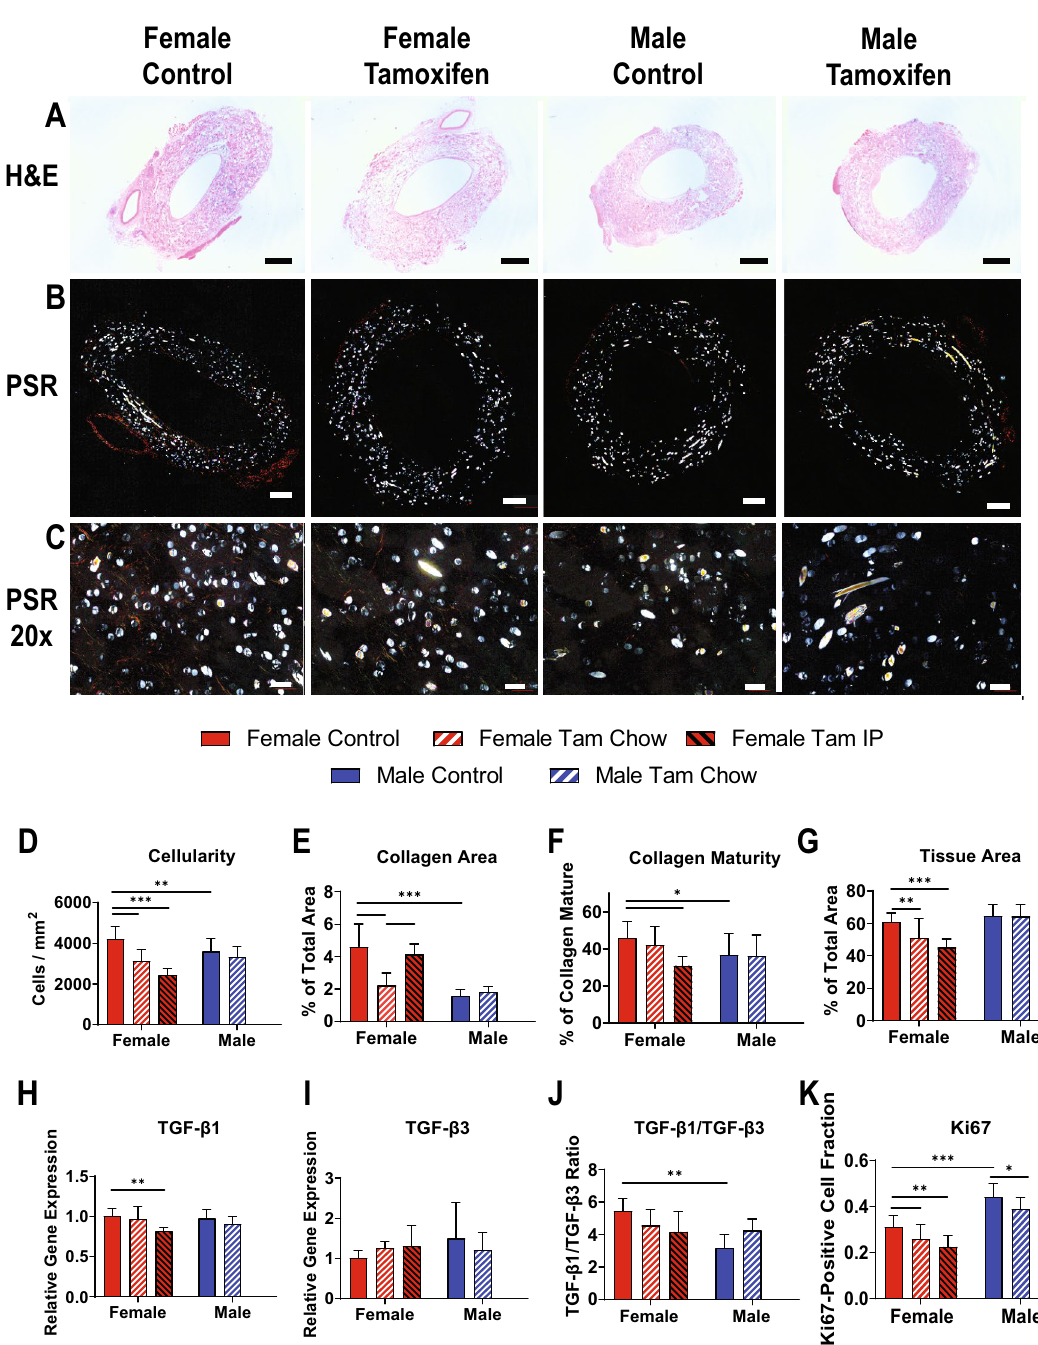
Figure 2. TEVG Neotissue Formation. ( A ) H&E imaging of TEVGs at the 2-week time point. ( B ) Picro-Sirius Red images under polarized light, with close-up of TEVG wall ( C ). White spots represent PGA fibers; red/ orange coloration represents mature thicker collagen fibers and yellow/green coloration represents thinner, immature collagen fibers, respectively. IHC quantifications of cellularity ( D ), tissue area ( E ), collagen area ( F ), collagen maturity ( G ), and Ki67 ( H ). RT-qPCR quantifications of TGF-β1 ( I ), TGF-β3 ( J ), and ratio of TGF-β1 to TGF-β3 ( K ). Scale bars = 0.5 mm ( A ), 200 µm ( B ) 20 µm ( C ). N = 15–20 for histology measures ( D – G ), and N = 6 for RT-qPCR measures ( H – K ), all compared using t-tests. * p < 0.05, ** p < 0.01, *** p <